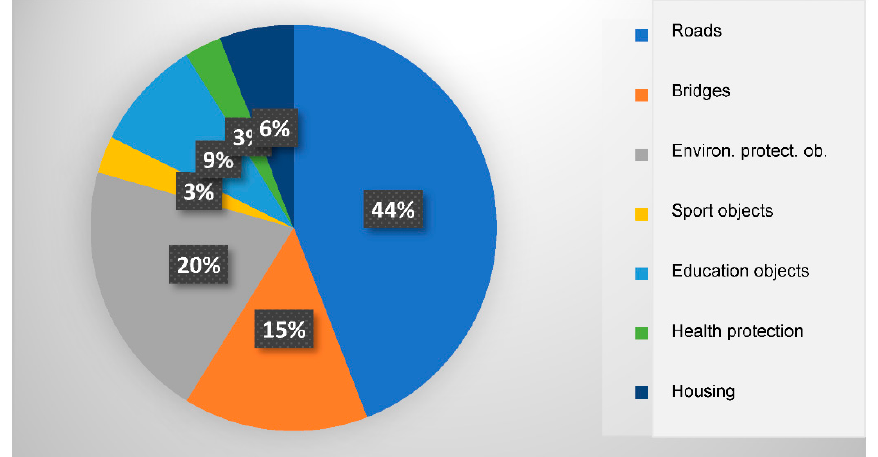
Figure 6. Participation in the study each types of civil structures.